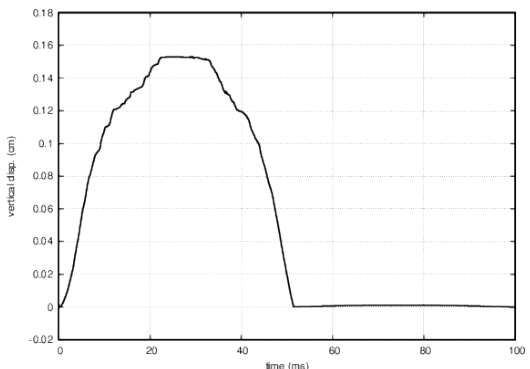
Figure 14. Vertical displacement of the right bottom corner of the